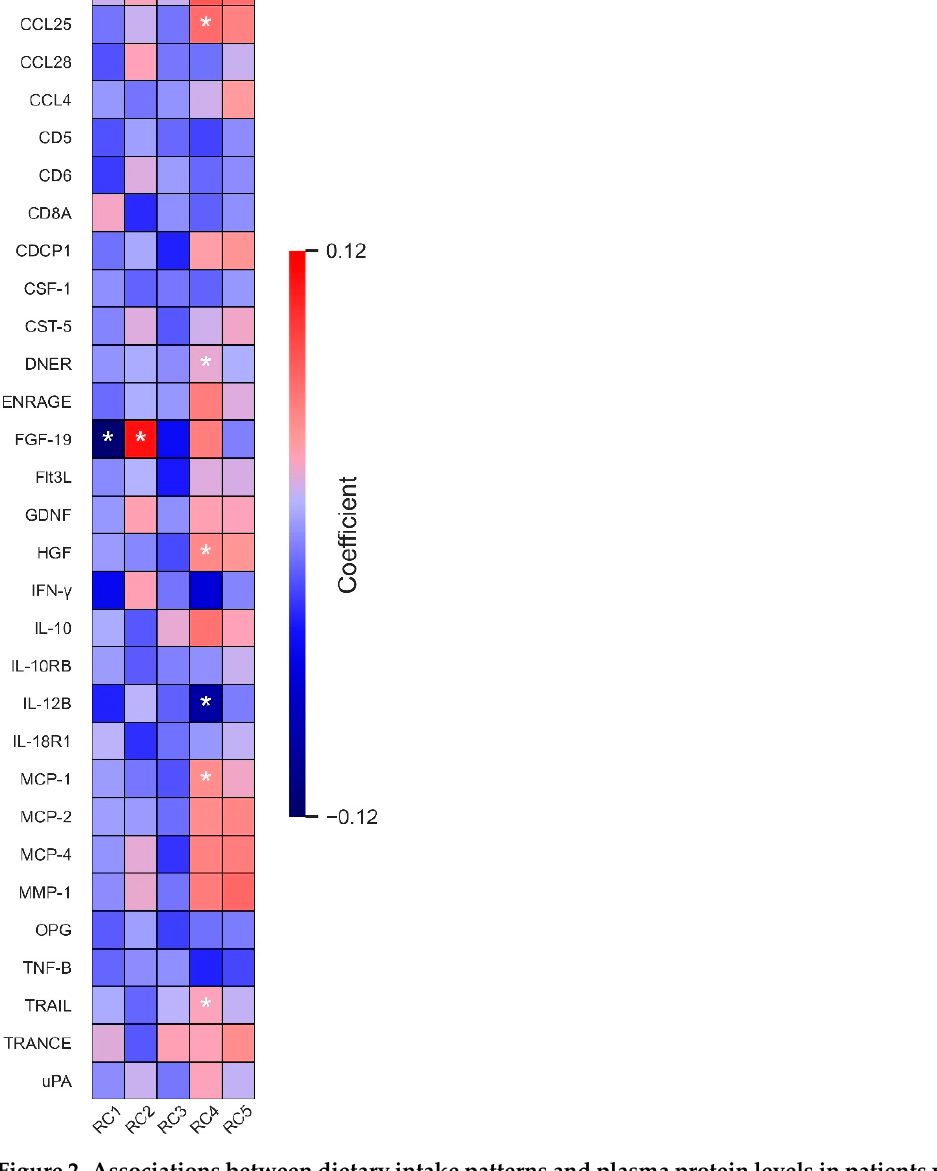
Figure 2. Associations between dietary intake patterns and plasma protein levels in patients with IBD. The heatmap indicates the size of the beta coefficients of the studied associations, only showing proteins that had at least one nominally significant association ( p < 0.05) with a dietary pattern. The first dietary pattern (RC1) was rich in refined carbohydrates, characterised by high intake of bread, spreads, pastry, sugar and sweets, savoury snacks and juice. The second dietary pattern (RC2) was a ‘Mediterranean-style’ dietary pattern, as evidenced by a high intake of fruit, fish, nuts, eggs, tea and cereals and a low intake of meat and non-alcoholic beverages. The third dietary pattern (RC3) was a rather mixed pattern with many processed or ready-made foods, characterised by high intake of sauces, pasta, ready-made meals, rice, alcohol, nuts and savoury snacks. The fourth pattern (RC4) was a typical ‘beverages pattern’, characterised by an exceptionally high intake of coffee and alcohol as well as spreads and dairy, but a low intake of tea. The fifth pattern (RC5) was a ‘Traditional Dutch’ dietary pattern, composed of a high intake of vegetables, potatoes, meat and legumes. Asterisks (*) indicate statistically significant associations (FDR < 0.05). Abbreviations: GLM, general linear model; RC, rotated component.